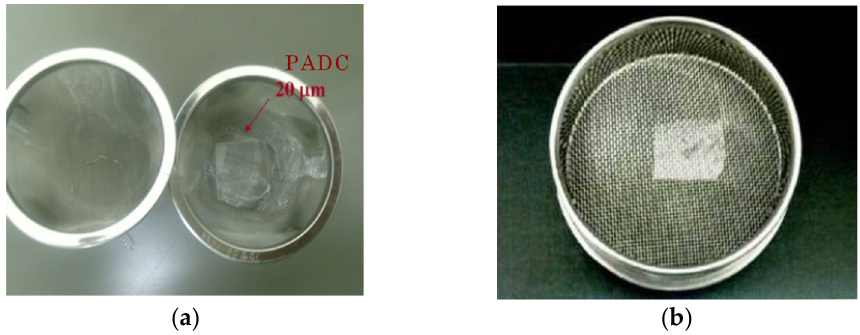
Figure 2. Photographs of PADC films during the thinning processes by chemical etching. The size of PADC films is 20 × 20 mm 2 . ( a ) PADC film with a thickness of 20 µm on stainless sieve, in the second step; ( b ) PADC film with a thickness of 20 µm in the final stage of etching on a stainless sieve with a flat base [12].